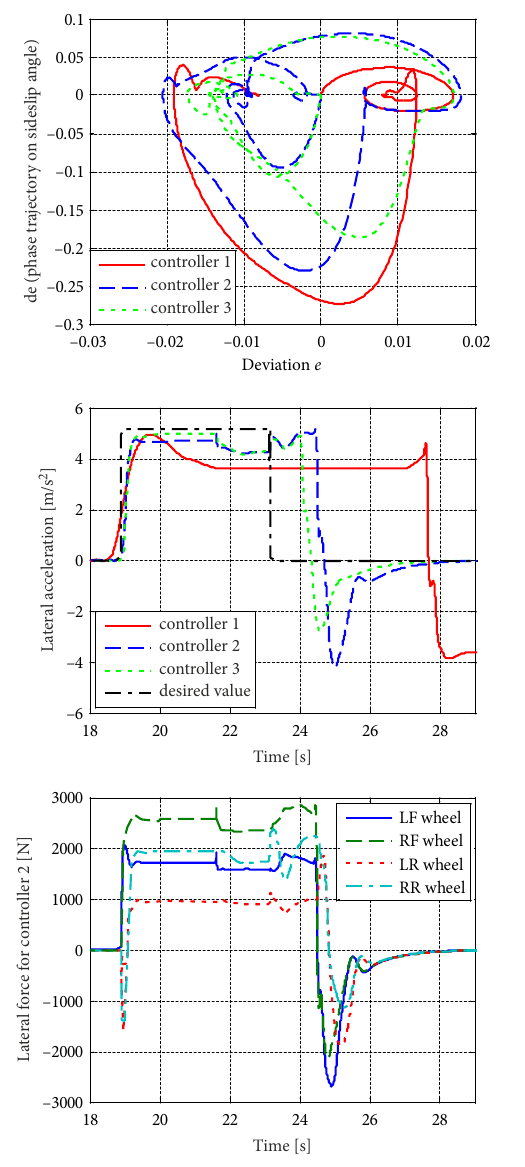
Figure 8. Simulation results in the anti-sideslip simulation: a – phase trajectories on the sideslip angle; b – phase trajectories on the roll angle; c – lateral acceleration; d – lateral forces for the red vehicle; e – lateral forces for the blue vehicle; f – lateral forces for the green vehicle